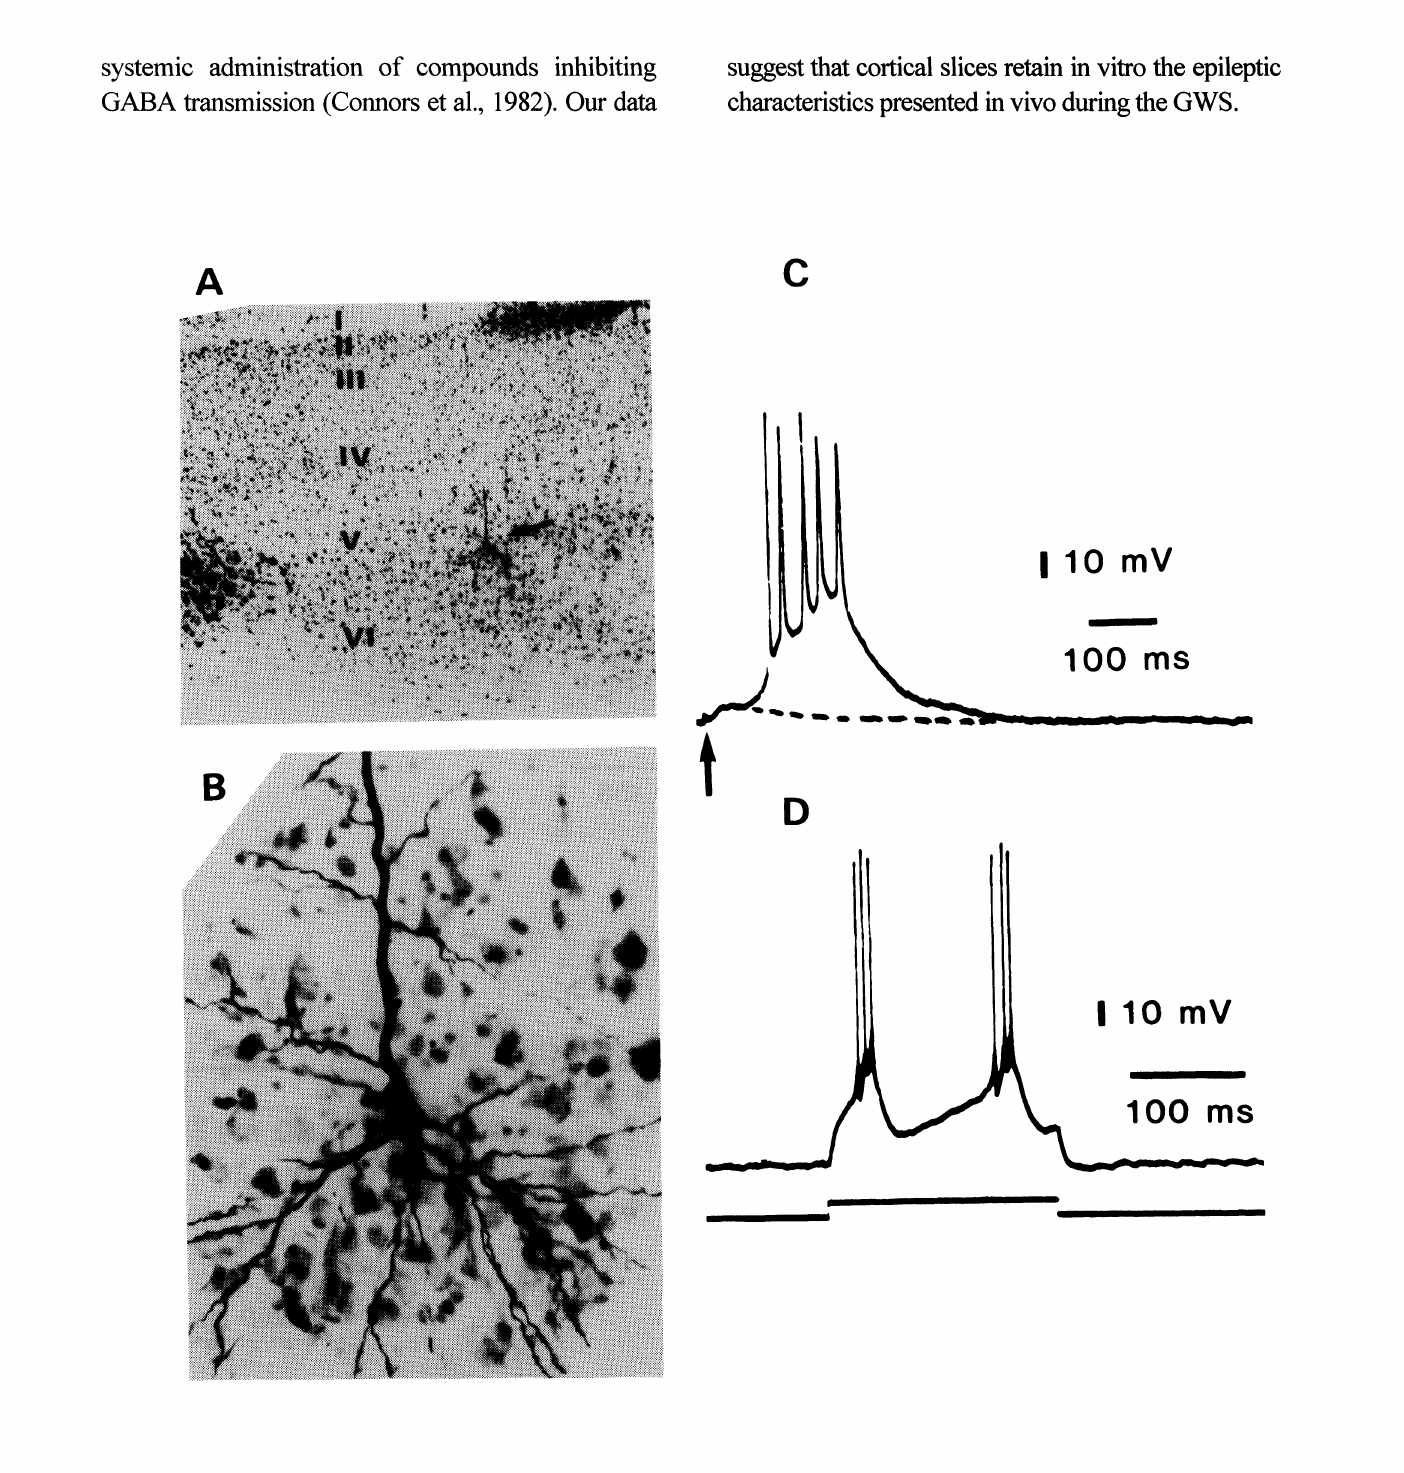
Fig. 1: Biocytin-labeled bursting neuron. A: photomicrograph of GABA infused site and a biocytin-labeled pyramidal neuron situated in layer V. Nissl-counterstained material (40). B: higher magnification photomicrograph of neuron. Note the important arborization of basal dendrites, the initial segment of the apical dendrite and the soma (190). C: paroxysmal depolarization shift induced in this neuron by suprathreshold white matter stimulation Em =-72mV superposed to an EPSP triggered by subthreshold stimulation (hatched line). D: Intrinsic burst induced in the same neuron by intracellular depolarizing current